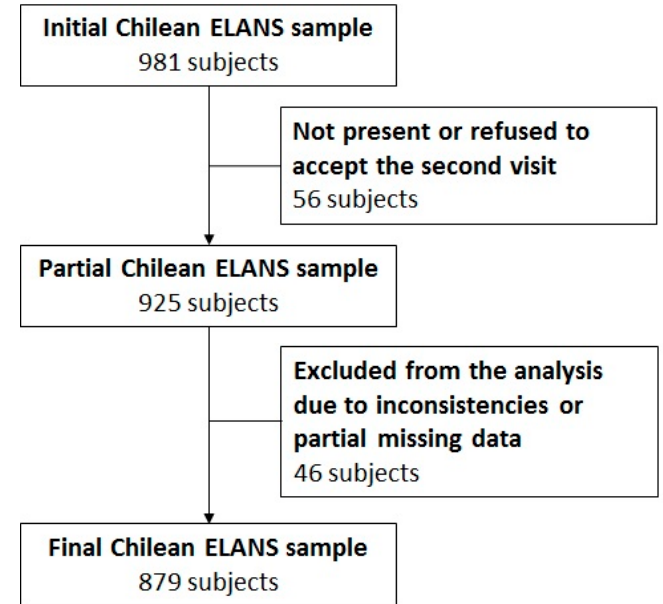
Figure 1. Flow diagram of the Chilean sample enrolled in the Latin American Study of Nutrition and Health (“Estudio Latinoamericano de Nutrición y Salud”; ELANS).